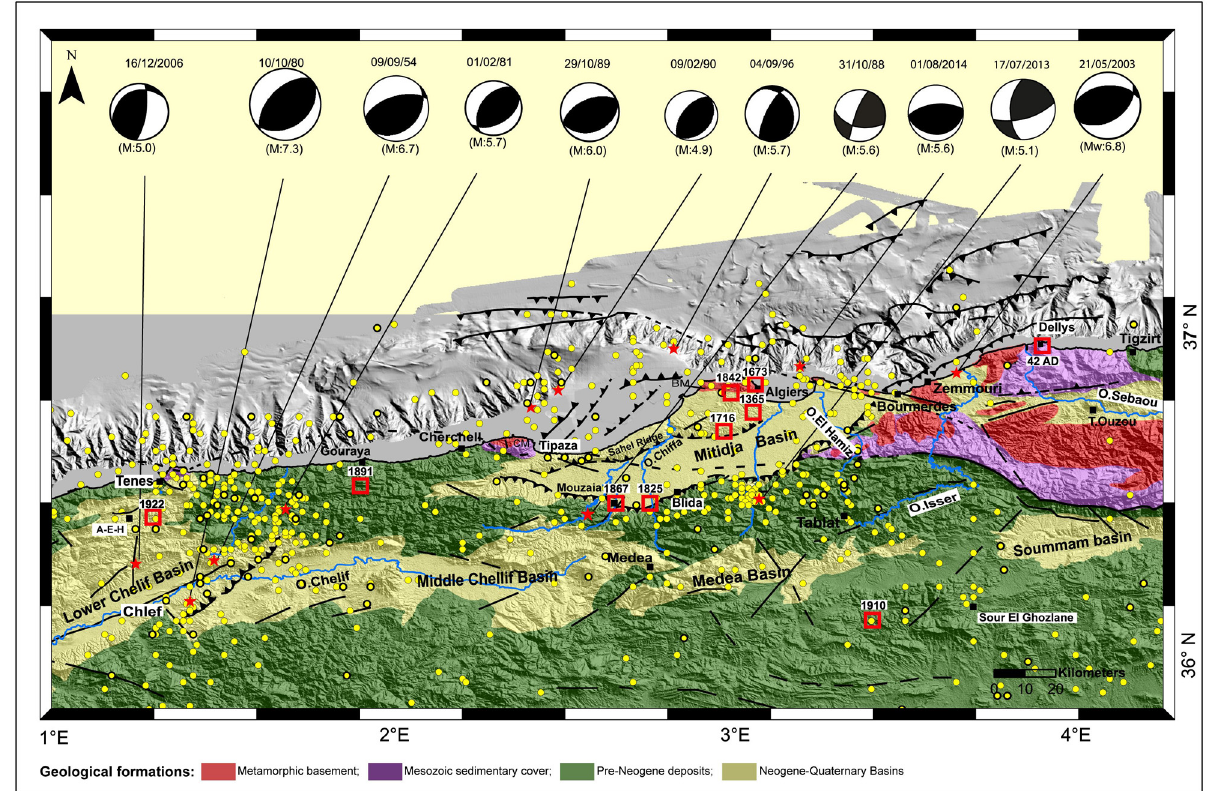
Figure 1. Seismotectonic map of Algiers and its surroundings. Shaded relief bathymetry from MARADJA2003 and MARADJA2005 cruises [Déverchère et al. 2005, Domzig et al. 2006, Kherroubi et al. 2009] and topography onland (90 m-SRTM DEM) map showing offshore faults [Domzig et al. 2006, Ayadi et al. 2008, Strzerzynski et al. 2010] and onshore faults [Meghraoui et al. 1988, Boudiaf 1996, Yelles et al. 2006] (back lines). Focal mechanisms of main shocks (Mw>4.9) [Deschamps et al. 1982, Delouis et al. 2004, Beldjoudi et al. 2011; ING, Instituto Geográfico Nacional, http://www.ign.es; GFZ, German Research Centre for Geosciences, www.gfz-potsdam.de; Harvard GCMT, Harvard Global Centroid-Moment-Tensor, http://www.globalcmt.org/] after 1980 are plotted as red stars. Red open squares show the location of significant historical earthquakes [Rothé 1950, Benouar 1994, Mokrane et al. 1994, Harbi et al. 2007a]. White dots correspond to instru- mental seismicity ( M >3) [Benouar 1994, Mokrane et al. 1994, Yelles-Chaouche et al. 2002, Yelles-Chaouche et al. 2011, Annual bulletins from Craag 2012 to 2015]. MC and MB show the Chenoua and Bouzareah Massifs,